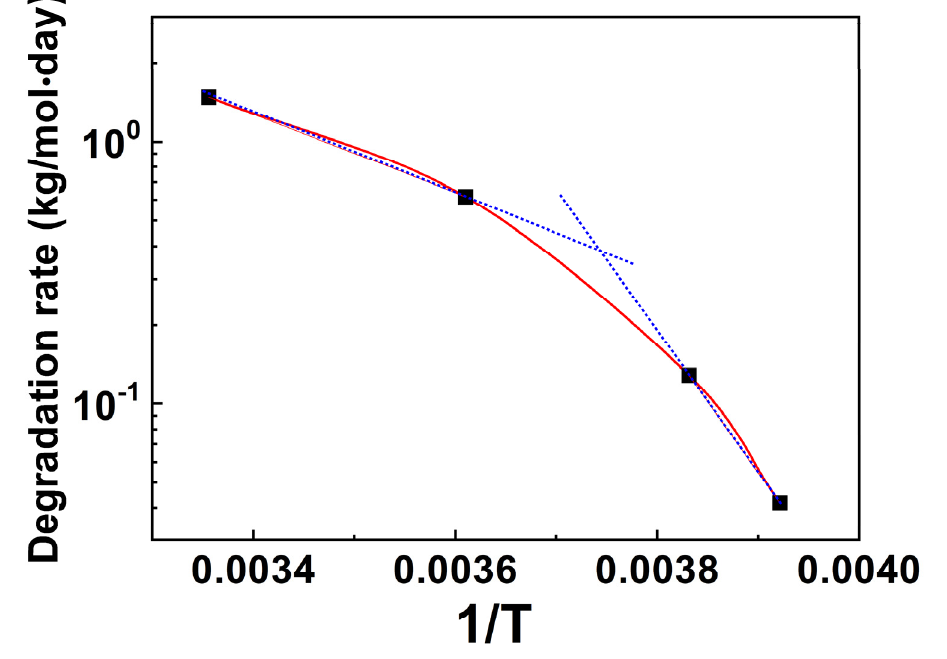
Figure 7. The log (degradation rate) vs. 1/T curve of (6FDA-DMB) PAA in a concentrated solution stored at − 18 °C, − 12 °C, 4 °C, and 25 °C. stored at − 18 ◦ C, − 12 ◦ C, 4 ◦ C, and 25 ◦